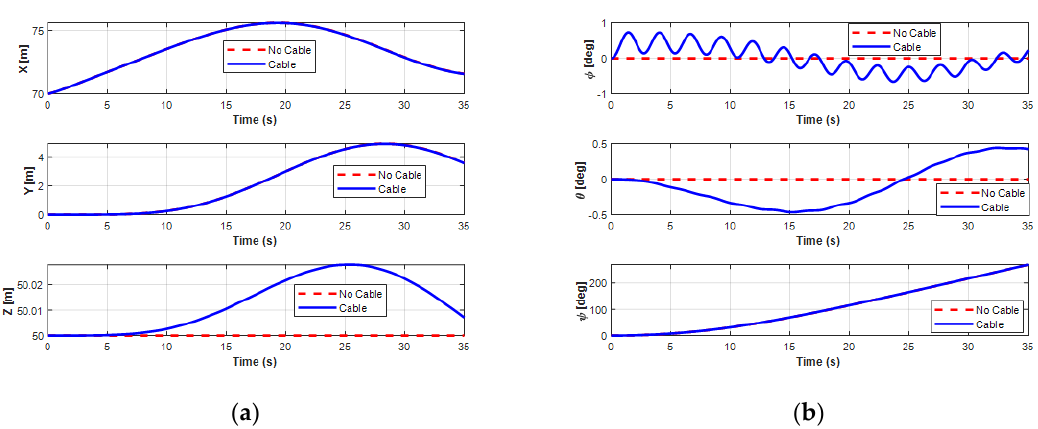
Figure 18. Simulation results of the position and orientation behaviors of the UUV turning: ( a ) position of the UUV; ( b ) orientation of the UUV.